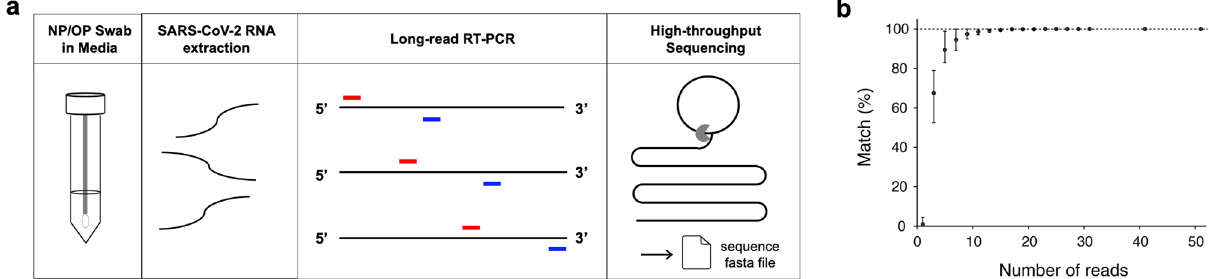
Figure 1. CorvGenSurv’s workflow and precision. (a) Remnant NP/OP specimens from COVID-19 diagnostic testing were subject to SARS-CoV-2 RNA extraction. Viral RNA was amplified via three overlapping RT-PCRs (~ 10,000 base long each) and pooled SARS-CoV-2 amplicons of indexed COVID-19 specimens were then sequenced by long-read high-throughput single-molecule sequencing. The output fasta file was de-multiplexed and processed to produce the consensus sequence of each segment. Each COVID-19 specimen’s three overlapping segments were assembled into a SARS-CoV-2 whole genome sequence. ( b) CorvGenSurv’s precision was tested by comparing the consensus sequence from a given number of reads with the USA-WA1/2020 control strain (GenBank: MN985325.1). When a consensus sequence was built from three reads, only 67% [52.4–78.9%] of the 1000 bootstrap runs’ resulting consensus sequences were consistent with the correct sequence. When the number of the reads was greater or equal to 31, all 1000 bootstrap runs resulted in the correct